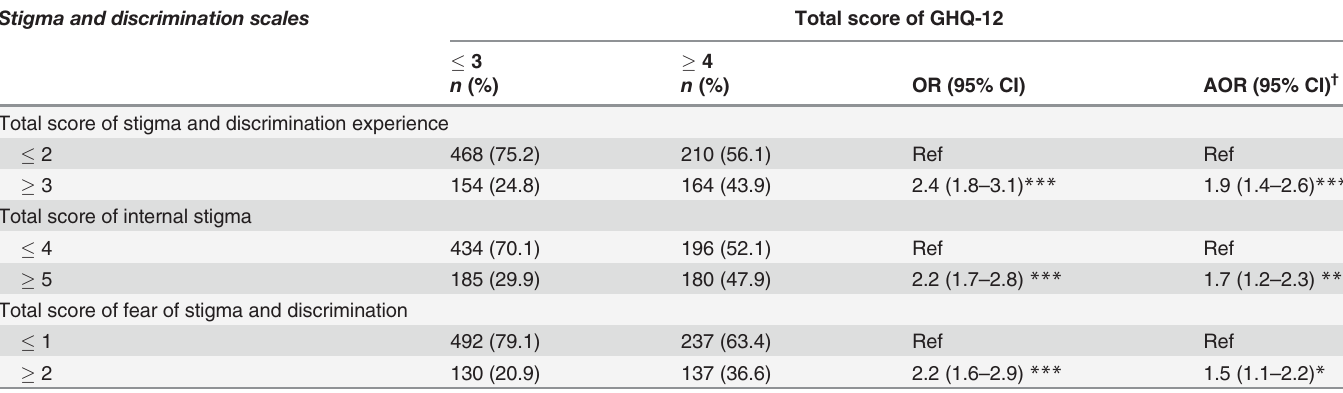
Table 5. Results of bivariate and multivariate logistic regression analyses of the association between stigma and discrimination with levels of mental disorders among PLHIV. Stigma and discrimination